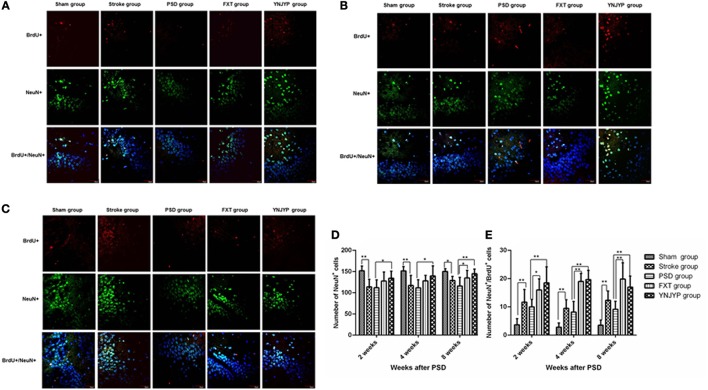
Effects of treatments on differentiation of newly formed cells toward neurons in PSD rats at 2, 4, and 8 weeks post-stroke. To observe the differentiation of newly formed cells toward neurons, recently divided cells were labeled with BrdU (red) and neurons were labeled with NeuN (green) at 2, 4, and 8 weeks. Cell nuclei were labeled with 4′,6-diamidino-2-phenylindole (blue). (A) At 2 weeks post-stroke. (B) At 4 weeks post-stroke. (C) At 8 weeks post-stroke. Scale bar = 30 μm. (D) The number of NeuN-positive cells at the observed dentate gyrus zone (at 2 weeks: F = 5.294, P = 0.003; at 4 weeks: F = 4.543, P = 0.007, at 8 weeks: F = 5.543, P = 0.002). (E) The number of cells double-positive for NeuN and BrdU at the observed dentate gyrus zone (at 2 weeks: F = 12.539, P = 0.001; at 4 weeks: F = 36.158, P < 0.001, at 8 weeks: F = 17.668, P < 0.001). n = 6; *P < 0.05, **P < 0.01. BrdU, 5-bromo-2-deoxyuridine; PSD, post-stroke depression; FXT, fluoxetine hydrochloride capsules; YNJYP, Yi-nao-jie-yu prescription.